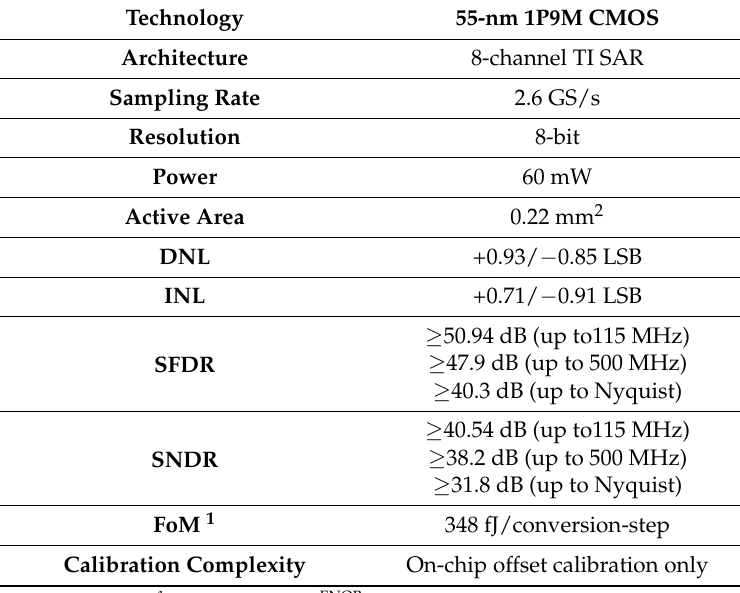
Table 1. Performance summary.